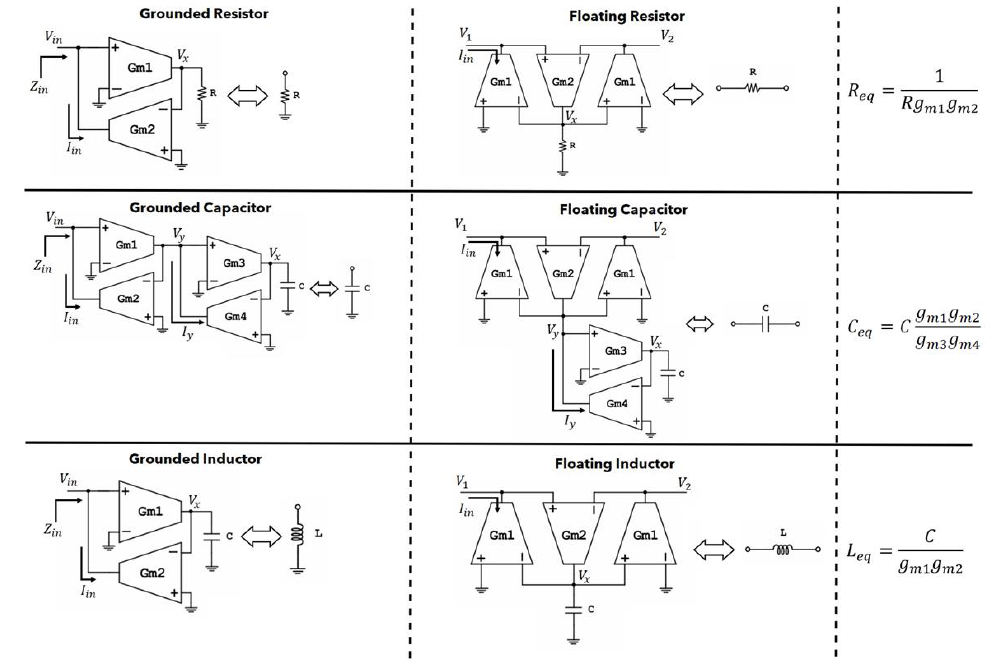
Figure 7. Passive component replacement using OTAs.